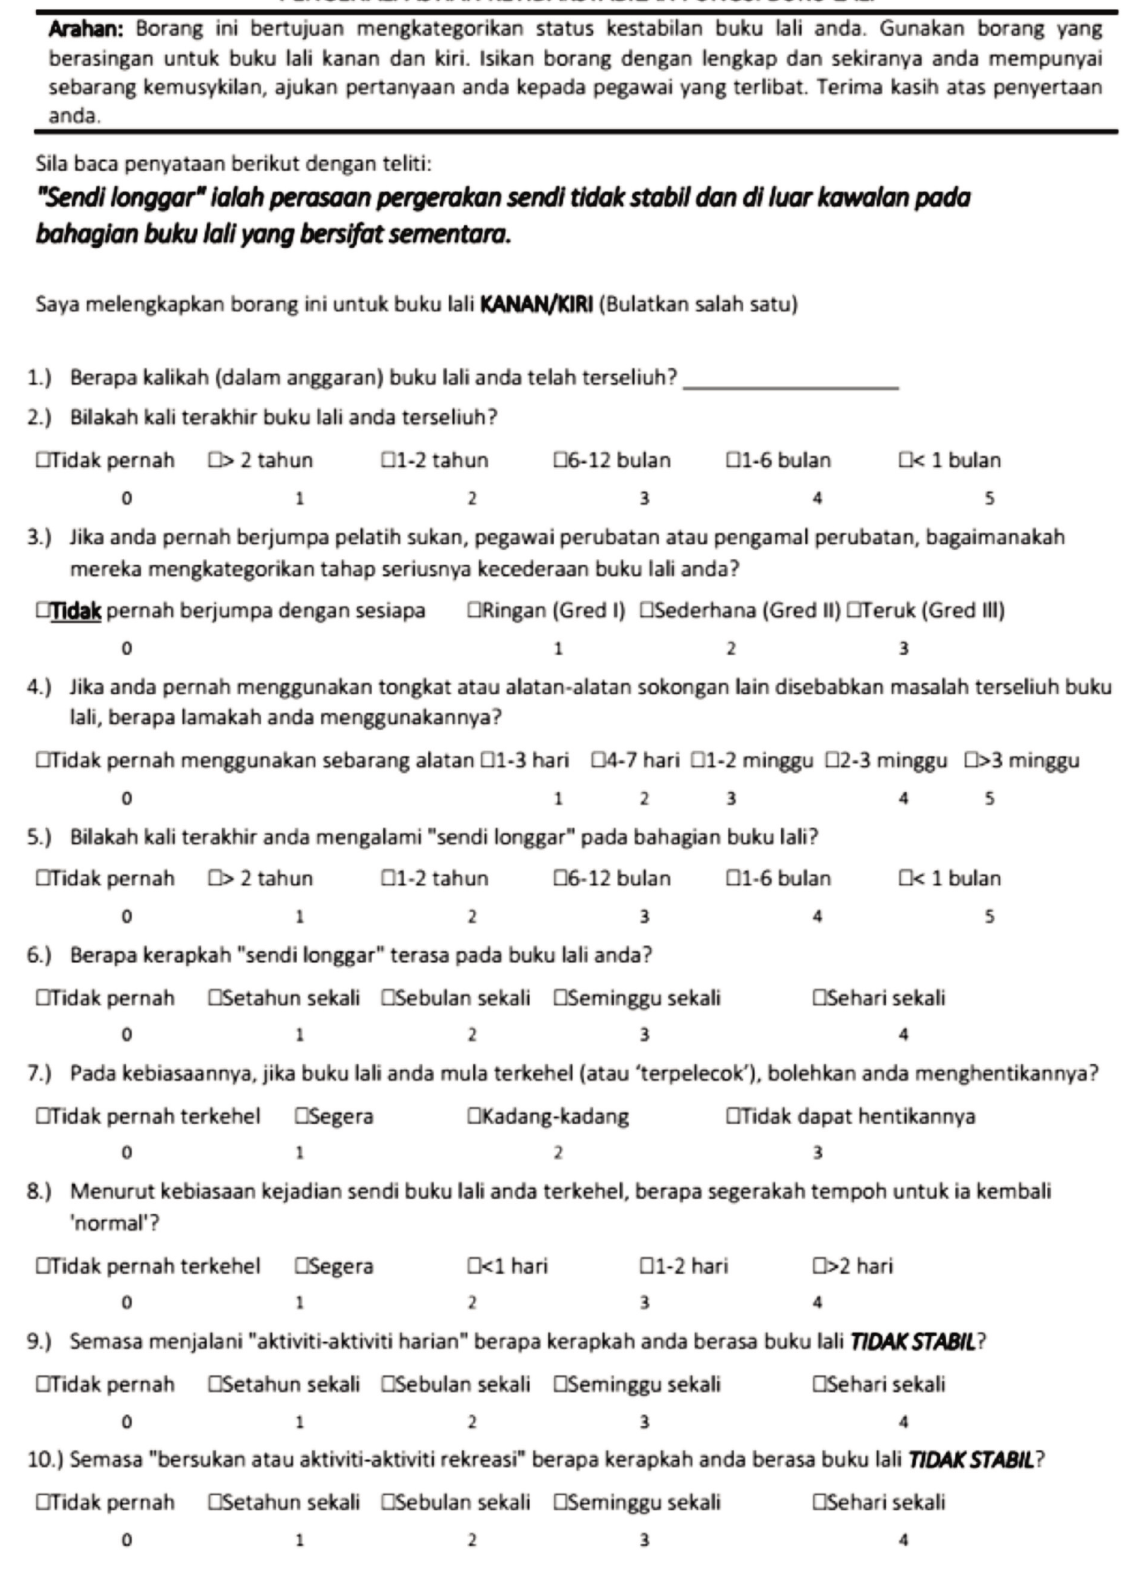
The Malay Version of the Identification of Functional Ankle Instabily Fig. 2: